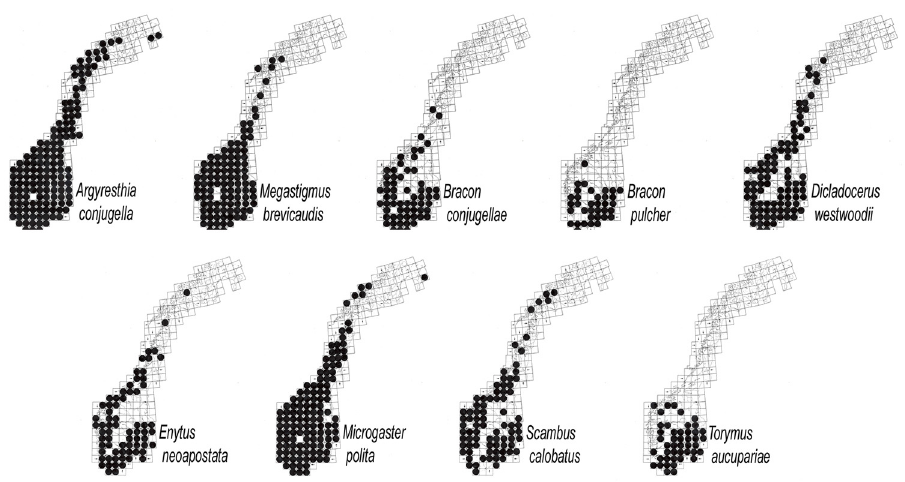
Figure 3. Geographical distribution of the insects commonly reared from rowanberries collected 1971–1984, plotted in The European Invertebrate Survey (EIS) grid of Norway [28]. Argyresthia conjugella and Megastigmus brevicaudis are seed predators; the others are parasitoids.